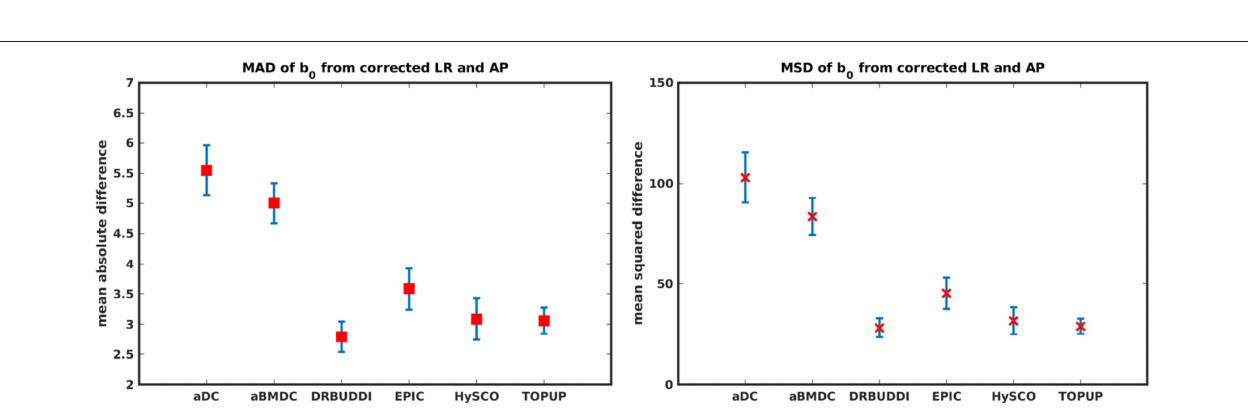
FIGURE 11 | MAD and MSD of b 0 from corrected LR and AP for five simulated HCP subjects using the six methods. The error bars represent the standard deviation over subjects. DR-BUDDI provides the smallest difference between the two corrections.